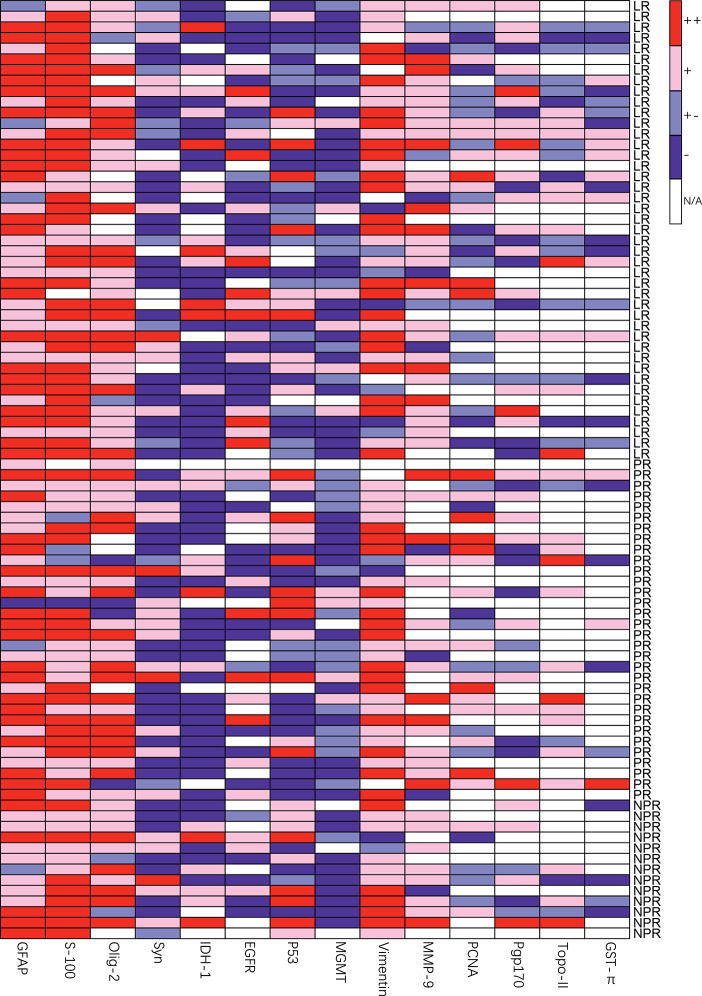
Heatmap of relative molecular markers expression of different groups, LR, local recurrence; PR, paraventricular recurrence; NPR, nonparaventricular recurrence.